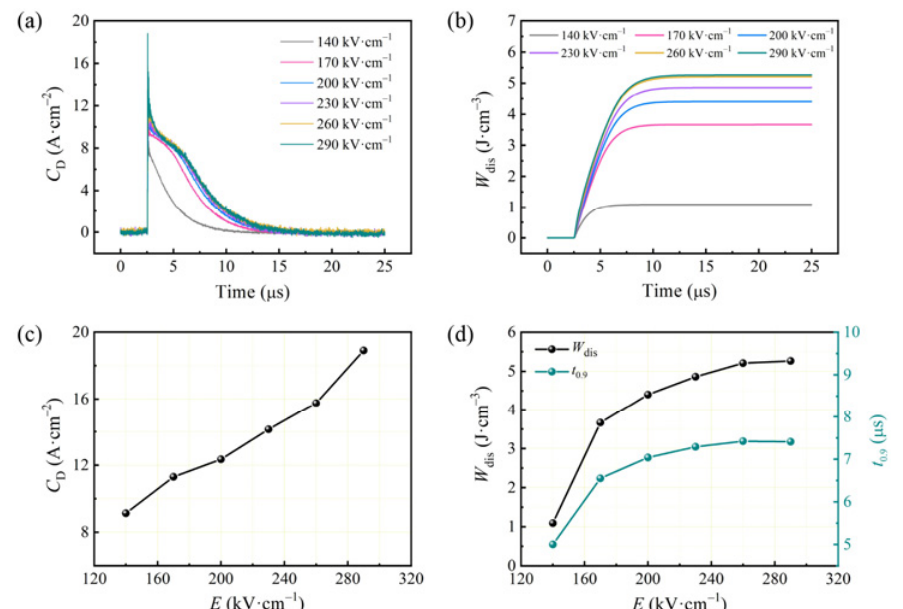
Fig. 8 Discharge properties of PBLZST:1.0 wt% AlN ceramics under different charging voltages: (a) Pulsed discharge current density ( C D )–time under electrical fields from 140 to 290 kV·cm − 1 , (b) Time-dependent W dis , (c) Peak C D , and (d) W dis and t 0.9 as functions of the external electrical field.